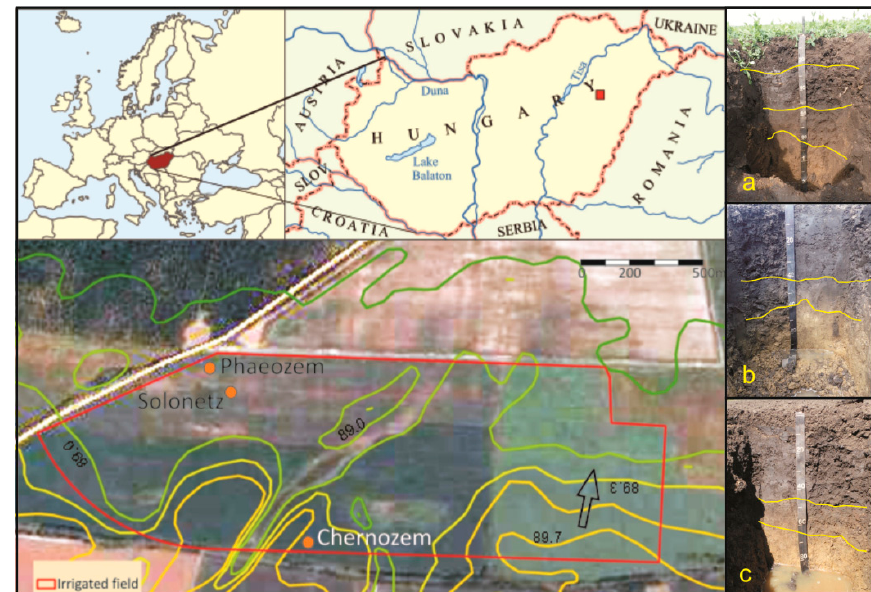
Figure 1. Location of the study area with elevation lines (m above sea level) and the investigated soil spots. The arrow indicates the slope direction (Google maps). Main soil types ( a ) Chernozem; ( b ) Solonetz; ( c ) Phaeozem. Table 1. Main properties of the investigated topsoils. SOM: soil organic matter. The particle size classes are in µm.